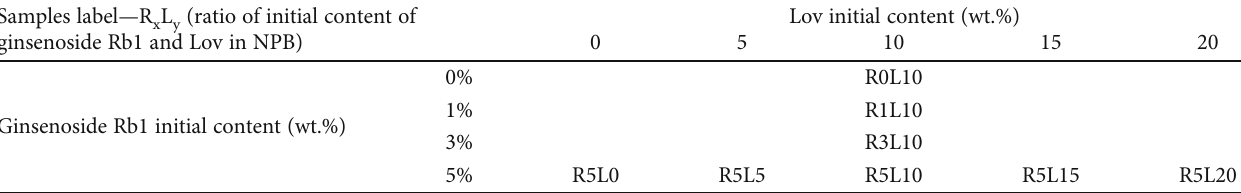
Table 1: Composition and label of NPB samples.